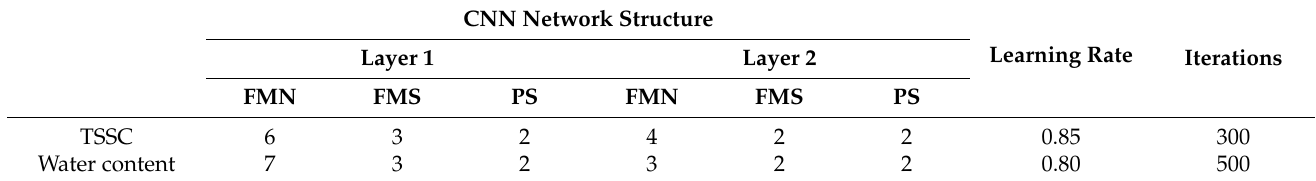
Table 1. Parameter setting for CNN feature